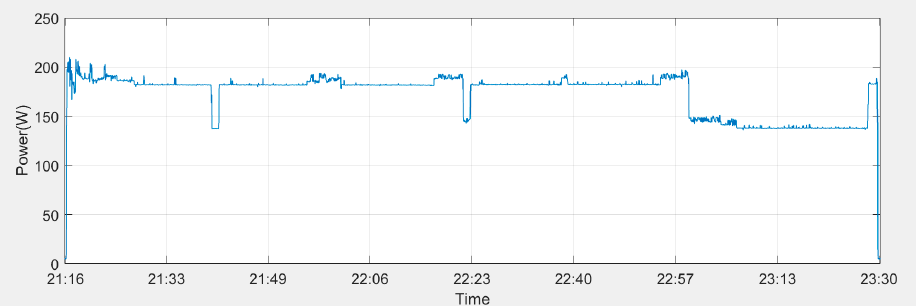
Figure 18. The power consumption curve of the desktop computer during one day utilization.